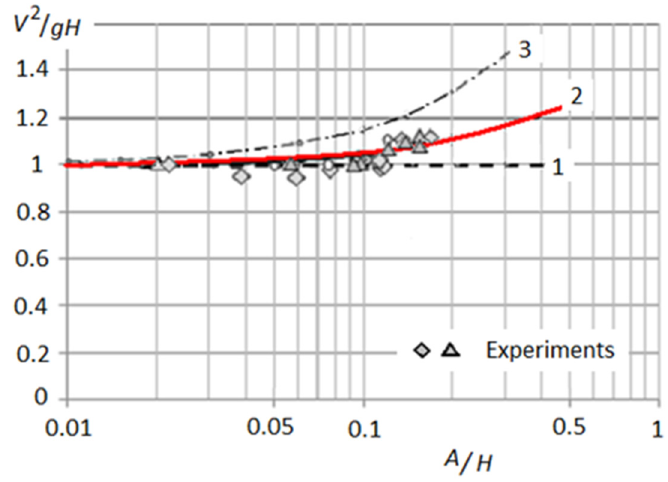
Figure 8. Dependence of long gravity waves velocity in the hydrodynamic channel on the nonlinearity parameter A/H : 1—linear theory of shallow water, 2—Navier–Stokes Equations, 3—nonlinear theory of shallow water (4 А ).